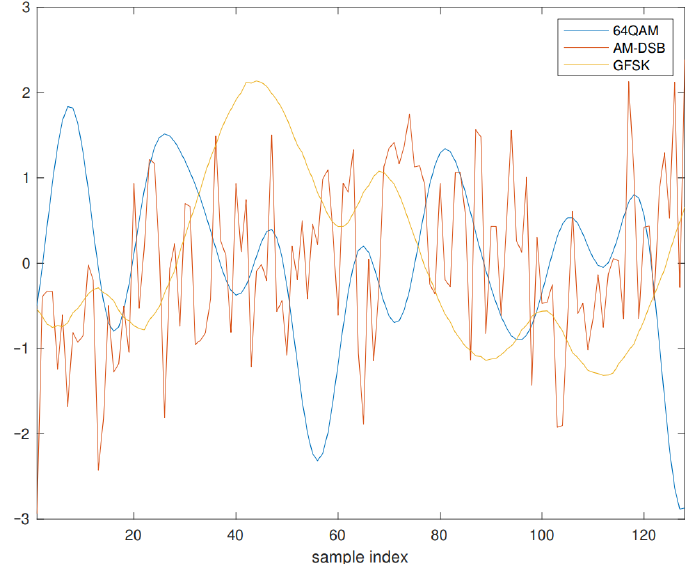
Figure 1. Illustration of typical 64QAM, AM − DSB, and GFSK in − phase waveforms. Therefore, the experiment considers 1000 samples x 1 , x 2 , . . . , x 1000 from each modu- lation type, with x k ∈ R 128 for all k . The signal to noise ratio (SNR), i.e., the ratio of the power of the signal to the power of the noise, is 18 dB. As a pre-processing step, we subtract from each vector x k the average of its components, which is equivalent to removing the DC value from each in-phase signal. Additionally, to equalize the power of all signals, all vectors x k are normalized to be of unit-norm. The small number of outliers detected (which actually appear to be mislabeled data) are filtered out and replaced by arbitrary waveforms of the same modulation type. Finally, all vector samples from the three modulations are put together in a matrix X ∈ R 128 × 3000 as